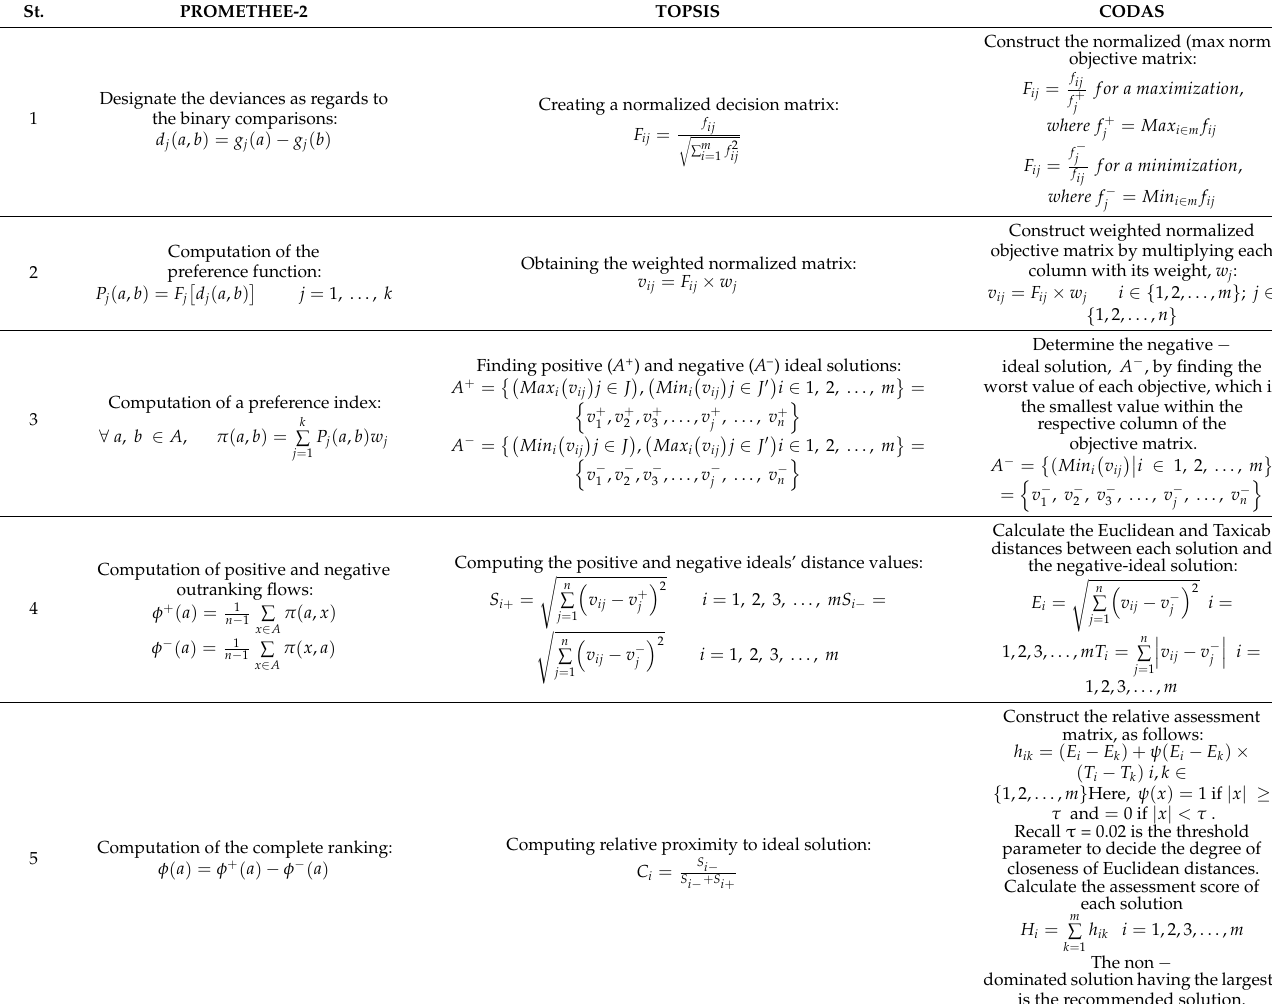
Table A1. Methodological Stages of PROMETHEE-2, TOPSIS and